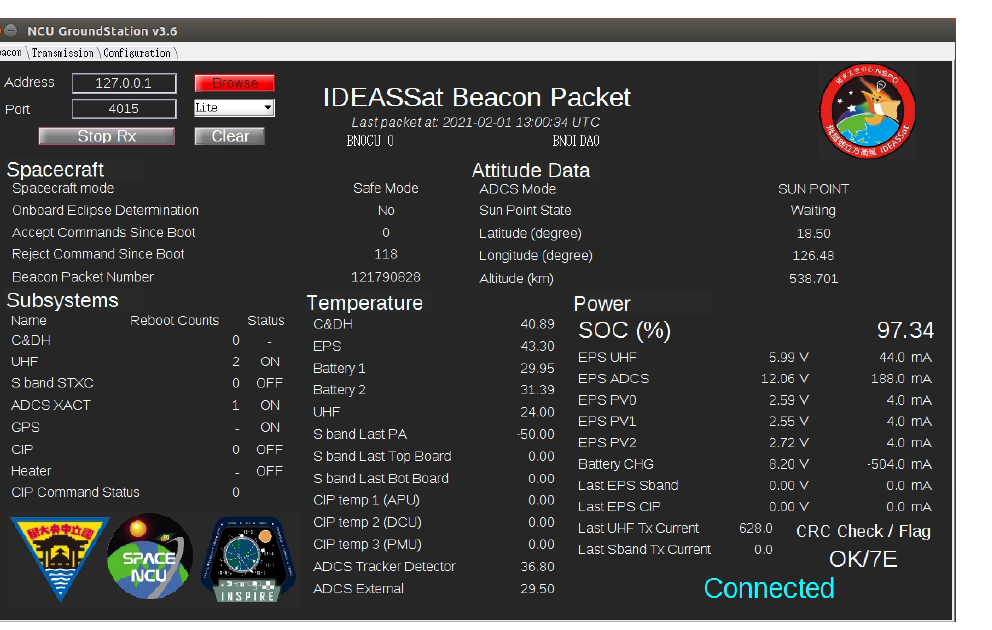
Figure 18. Contents of the first IDEASSat beacon received by the NCU ground station.